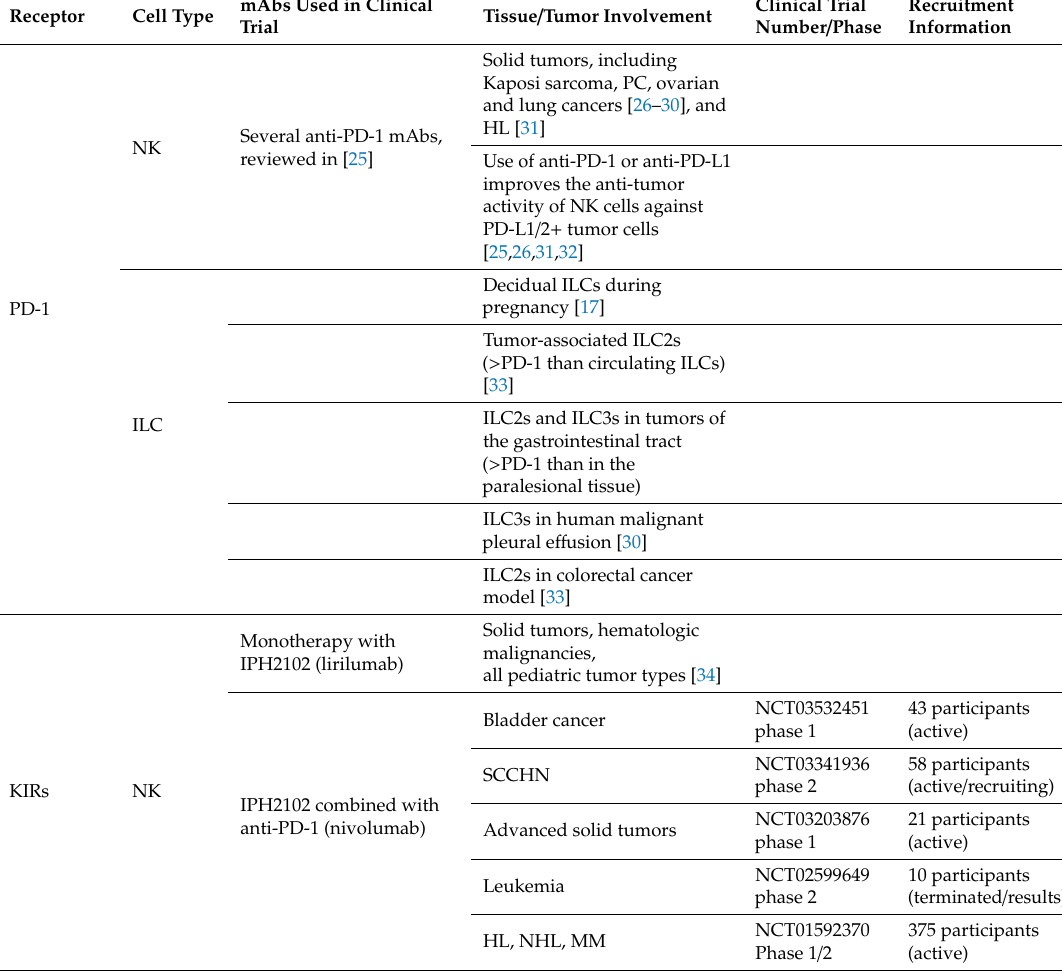
Table1. Currentevidenceofimmunecheckpointexpressedininnatelymphocytesandtheirinvolvement in cancer